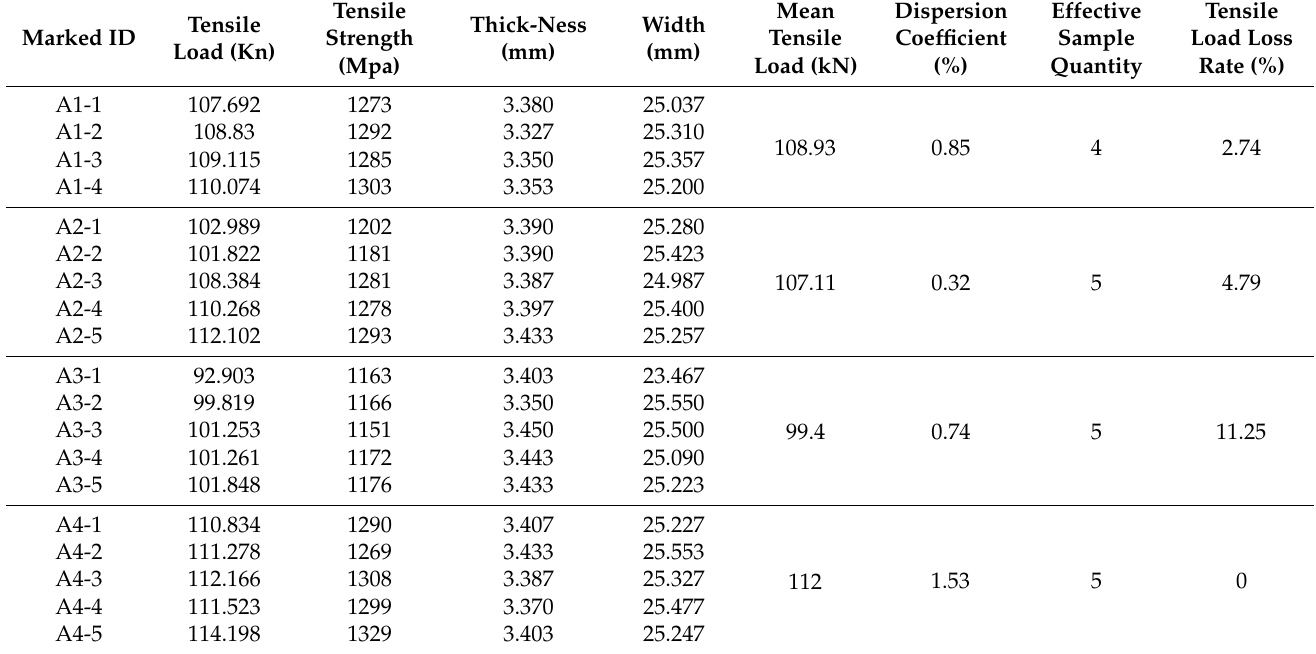
Table 2. Static tensile test results of